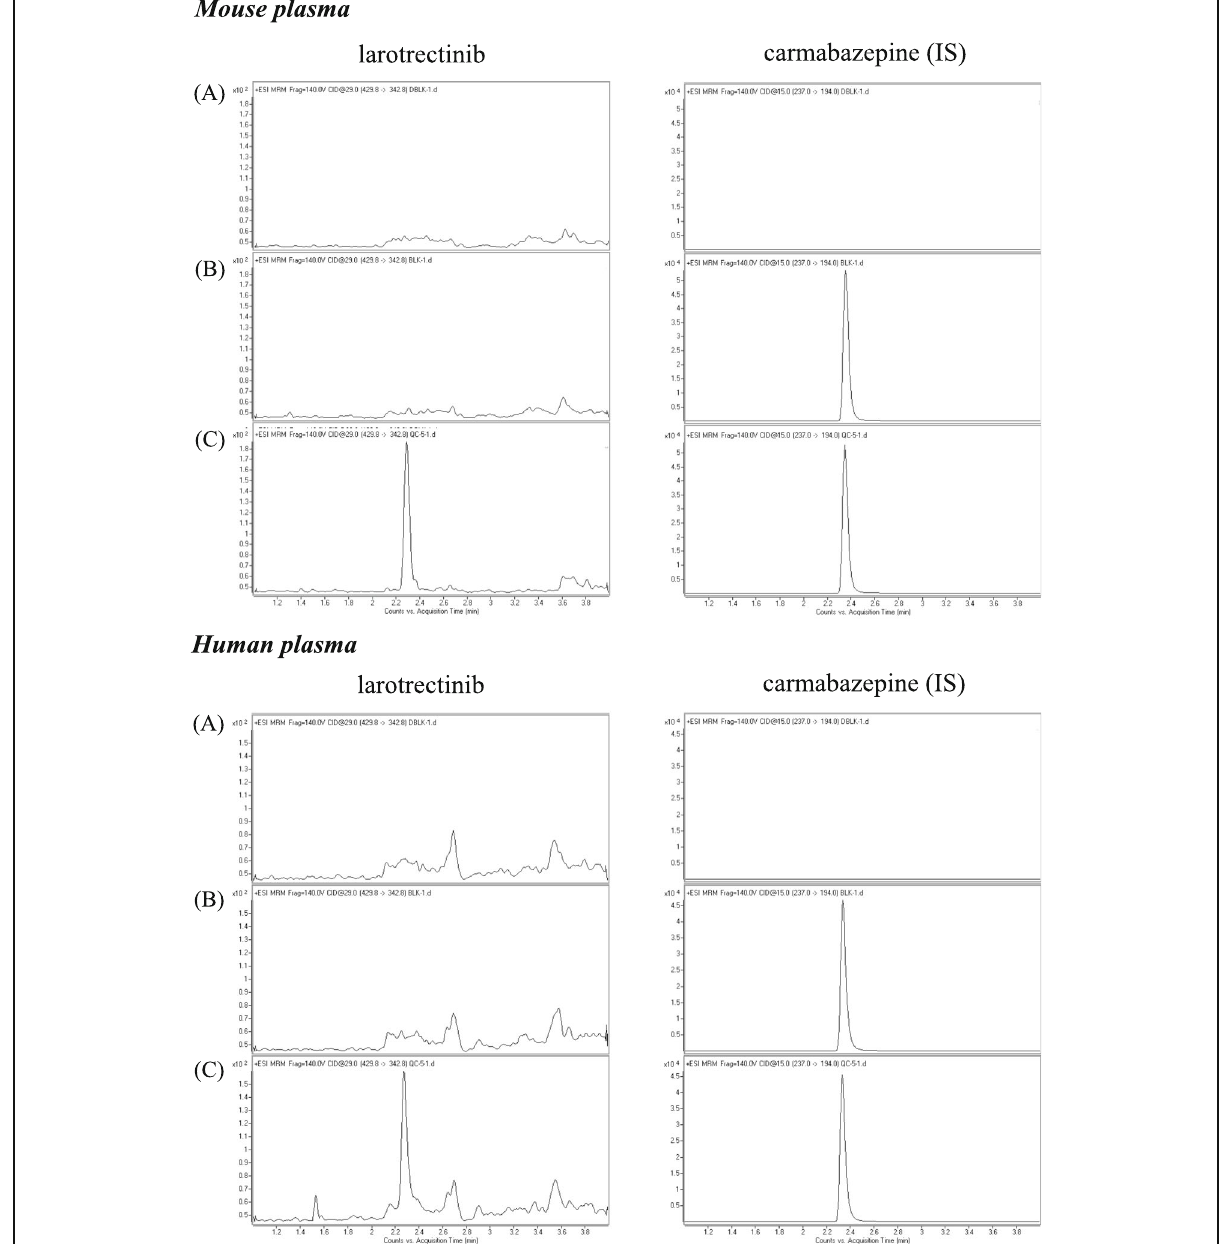
Fig. 2 Representative MRM chromatograms of a double blank plasma, b blank plasma spiked with IS, and c blank plasma spiked 5 ng/mL (LLOQ) of larotrectinib and